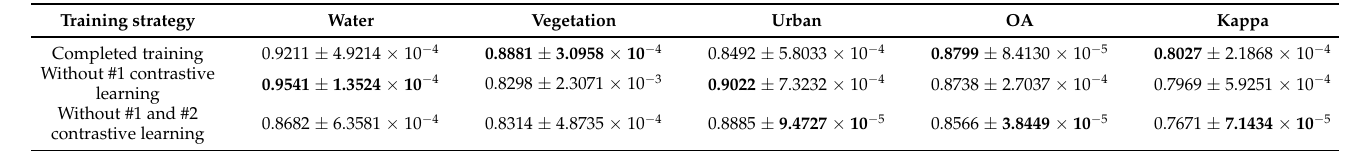
Table 9. Classification Results of Xi’an by using different training strategies, where the highest mean and lowest variance for each category are marked in